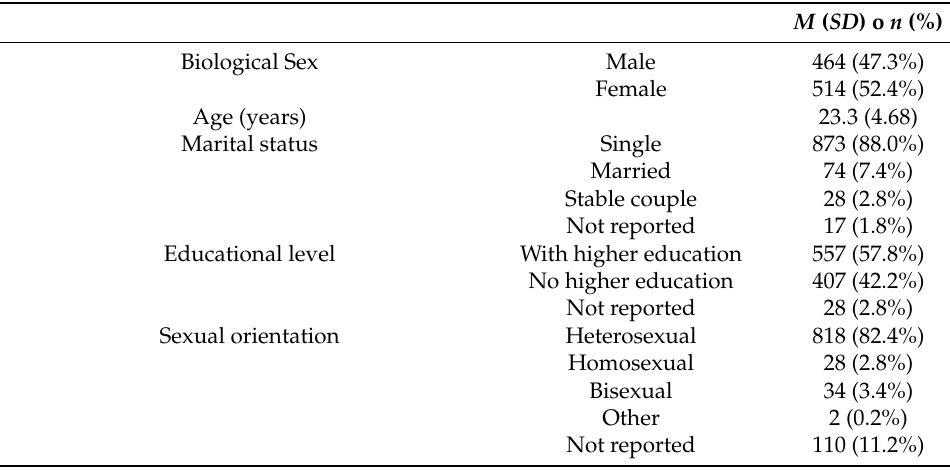
Table 1. Sociodemographic characteristics of the sample.